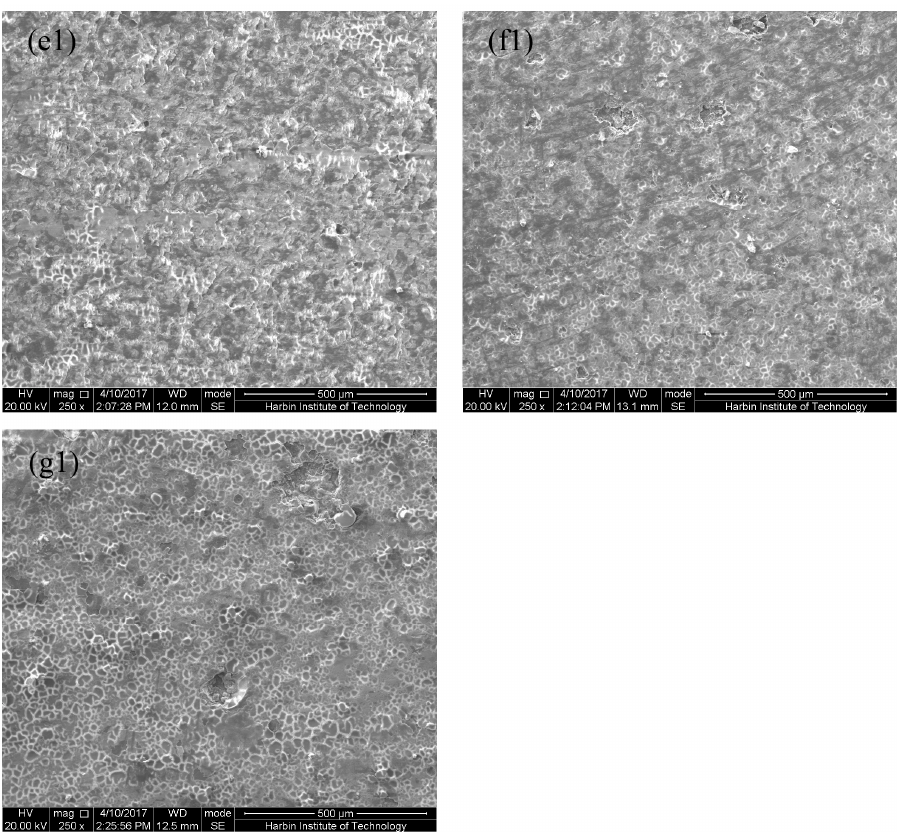
Figure 7. The surface morphologies of the microarc oxidation self-lubricating composite coatings formed on aluminum alloys at different anode pulse-widths. ( a1 ) 1000 μ s; ( b1 ) 1500 μ s; ( c1 ) 2000 μ s; ( d1 ) 2500 μ s; ( e1 ) 3000 μ s; ( f1 ) 3500 μ s; ( g1 ) 4000 μ s.